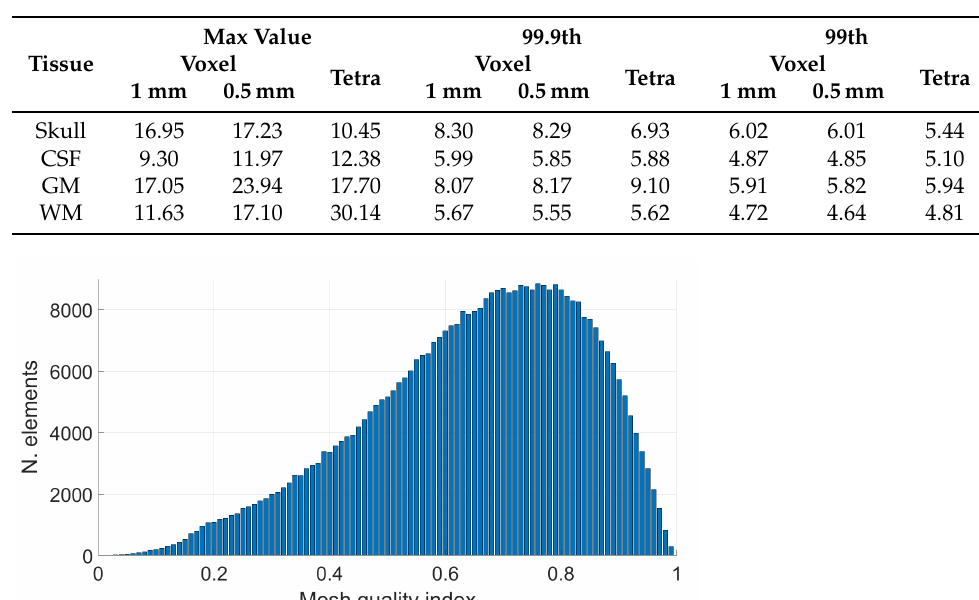
Figure 7. Tetrahedral mesh quality of Colin27 3D model. The quality index is on the x -axis, while the number of tetrahedral elements corresponding to the respective mesh quality index is shown on the y -axis.